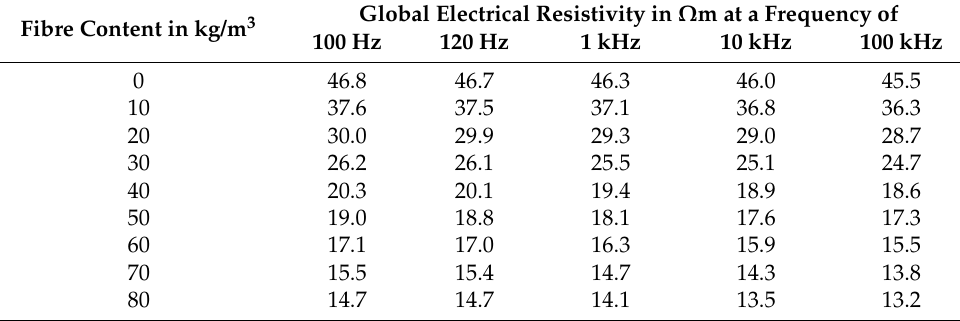
Table A28. Results of the resistivity measurements of the concrete mixture 32-65-330-65. Fibre Content in kg/m